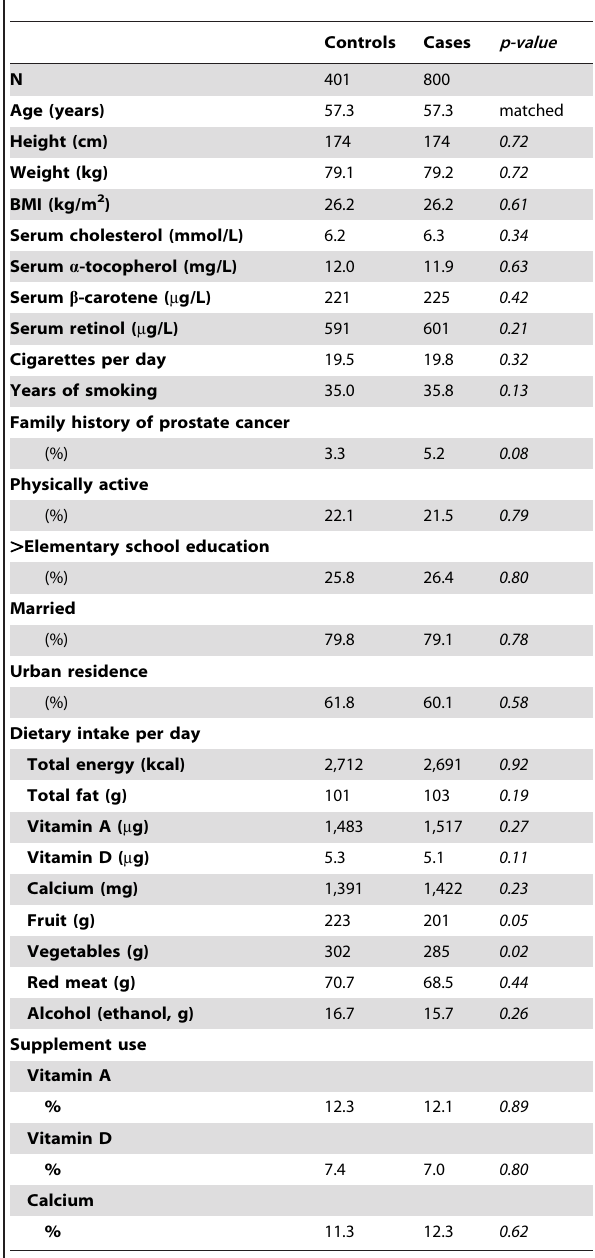
Table 1. Age-adjusted * baseline { characteristics by case- control